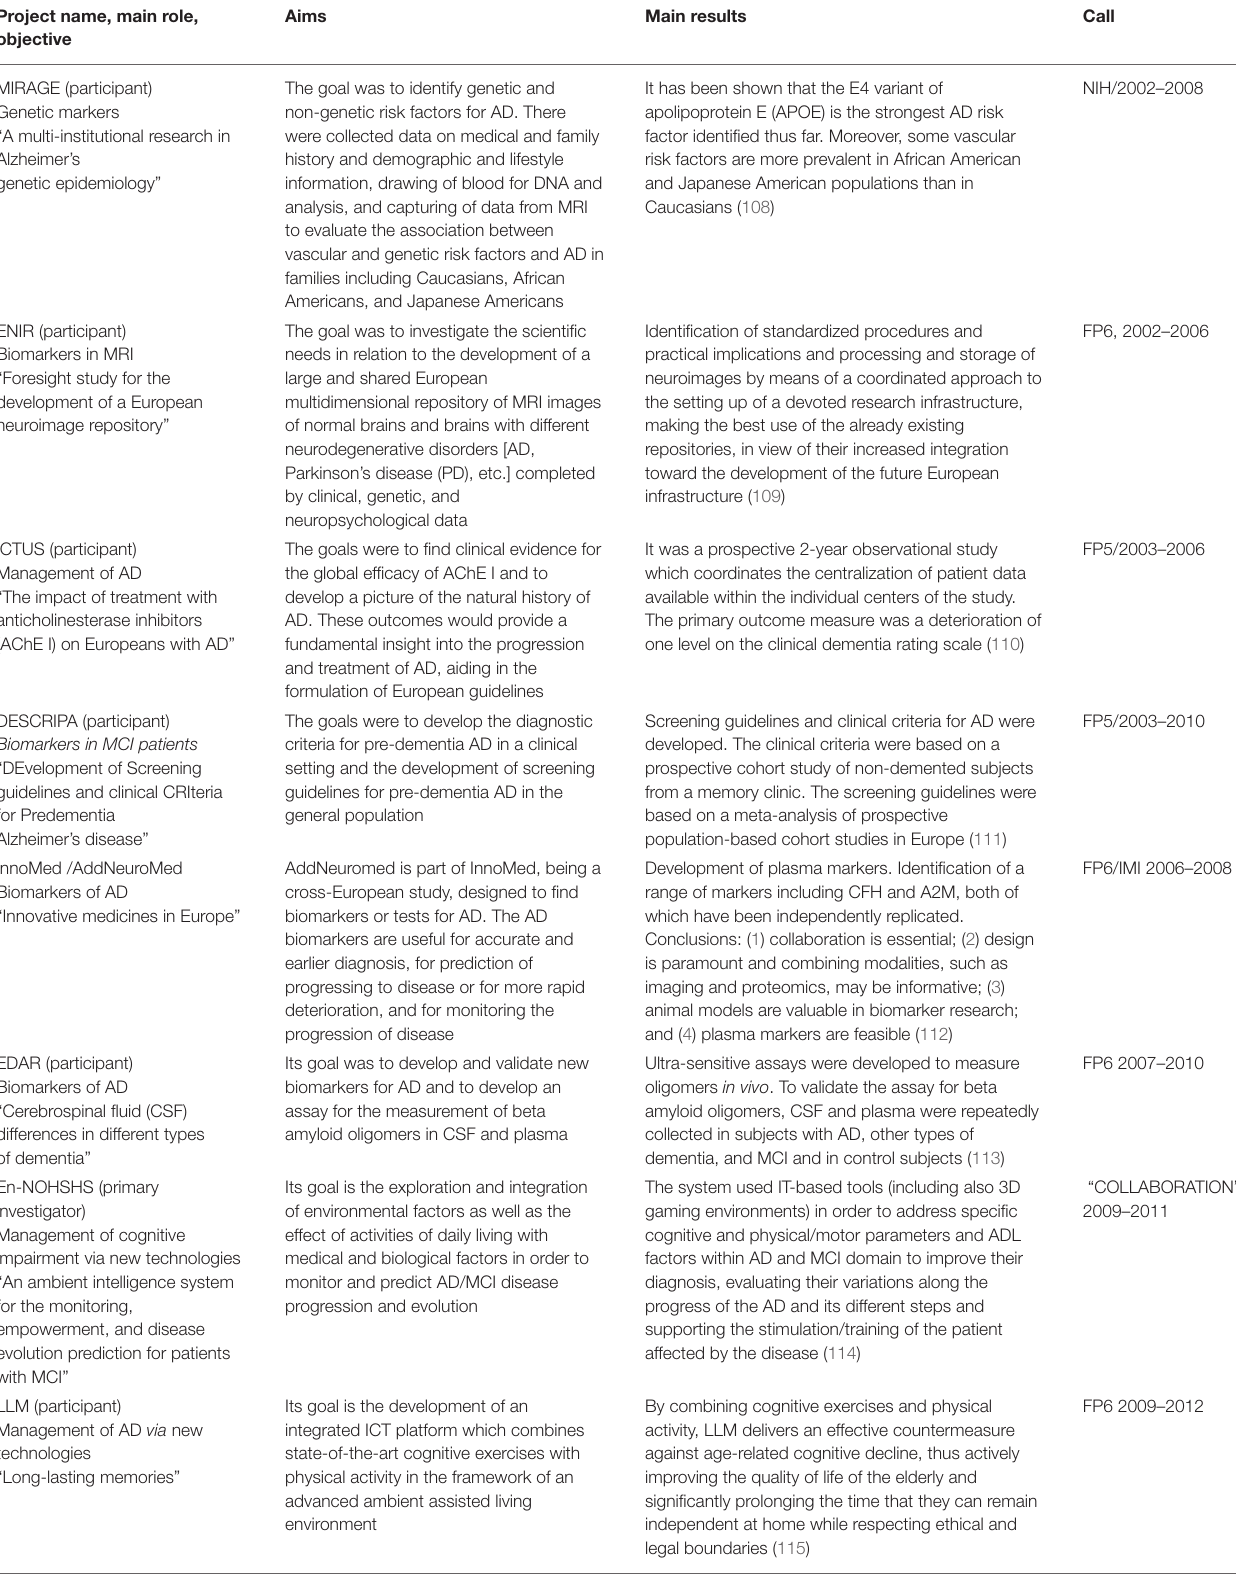
TABLE 5 | Research studies and